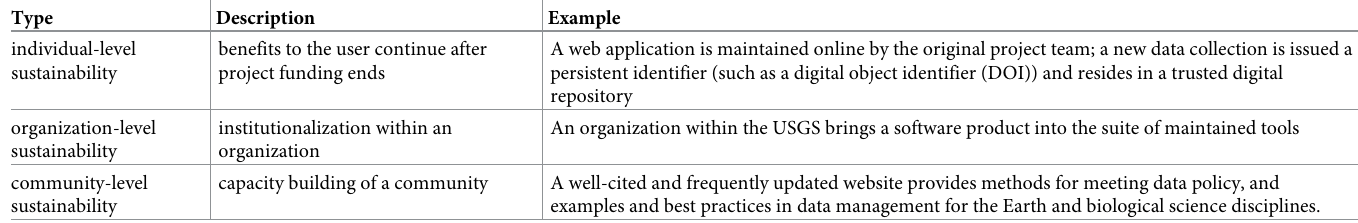
Table 2. Categories of sustainability evaluated in this study (following Shediac-Rizkallah and Bone [7]).